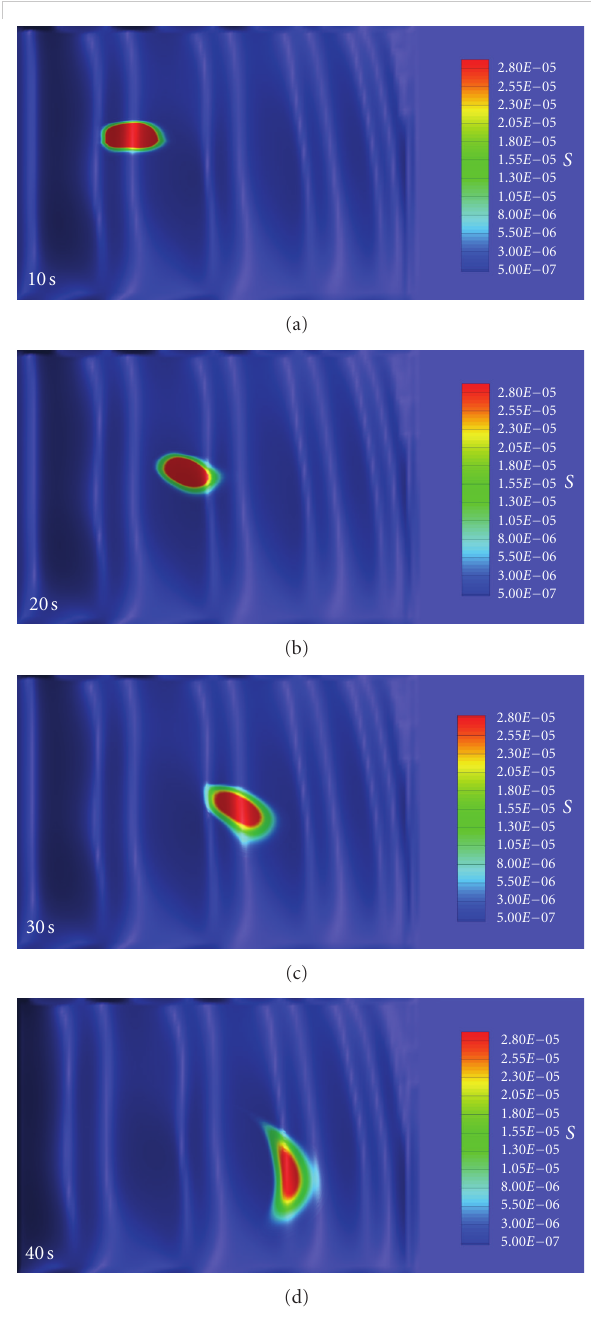
Figure 9: Development of 6 μ m oil thickness contours in numerical model in 4